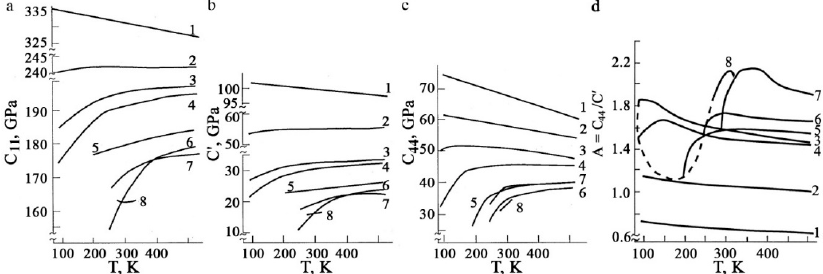
Figure 1. Temperature–concentration dependences of elastic constants: ( a ) C 11 , ( b ) C’, ( c ) C 44 and ( d ) elastic anisotropy parameter A = C 44 /C’ of the single-crystalline alloys: 1—Ti 50 Fe 50 , 2—Ti 50 Ni 25 Fe 25 , 3— Ti 50 Ni 35 Fe 15 , 4—Ti 50 Ni 40 Fe 10 , 5—Ti 50 Ni 45 Fe 5 , 6—Ti 50 Ni 48 Fe 2 , 7—Ti 50 Ni 50 and 8—Ti 49 Ni 51 [11]. (Reproduced with permission from Khachin V.N.; Muslov S.A.; Pushin V.G.; Chumlyakov Y.I., 1987, DAN SSSR).